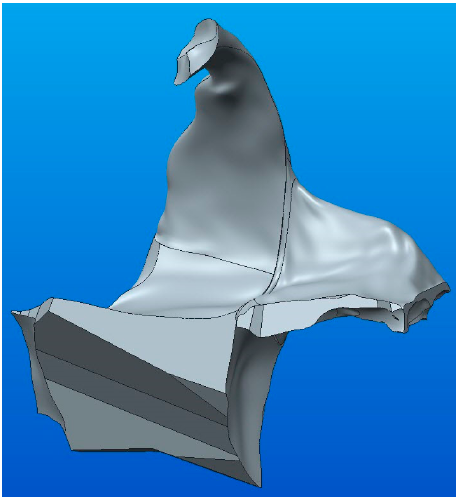
Figure 15. The complete parametric solid model resulting from the union of components A and B.